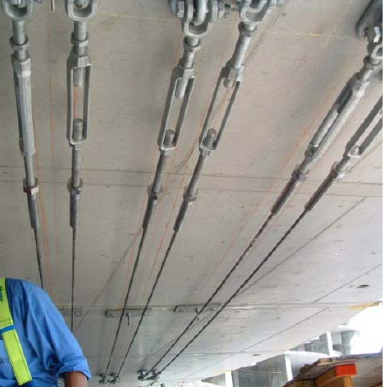
Figure 27. External post-tensioning with carbon FRP tendons.